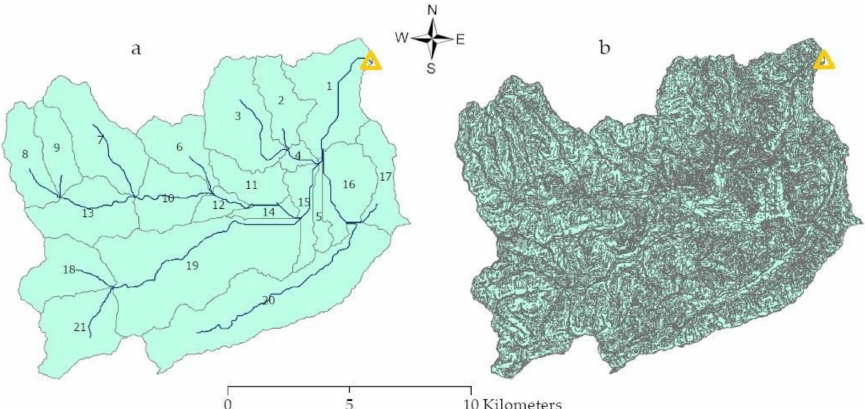
Figure 3. Sub-basin delineation ( a ) and HRU distribution ( b ) in the Yellow Creek Watershed. Blue lines show stream networks, and the yellow triangle represents outlet